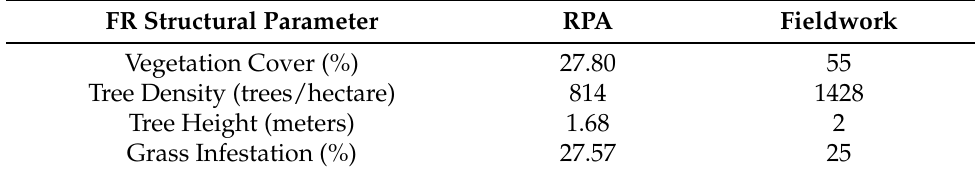
Table A1. RPA and fieldwork data